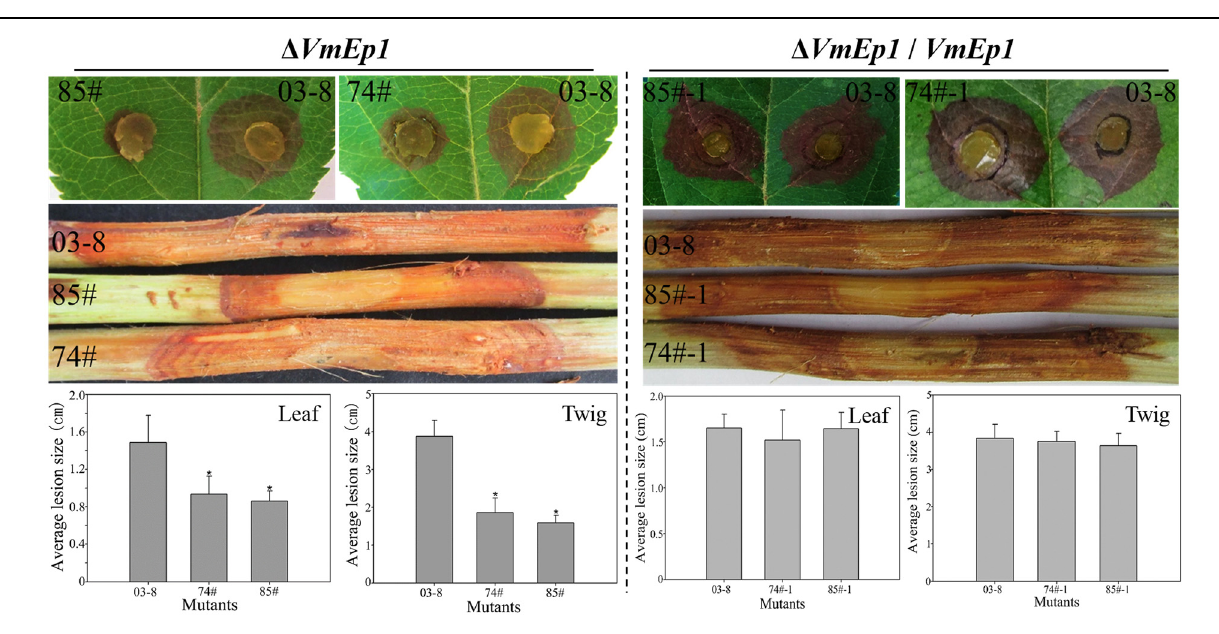
60 h, or 5 days, respectively. Asterisk represents a significant difference in pathogenicity ( P < 0.05). Bars indicate standard deviation of the mean of 30 individual host plants. The experiment was repeated three